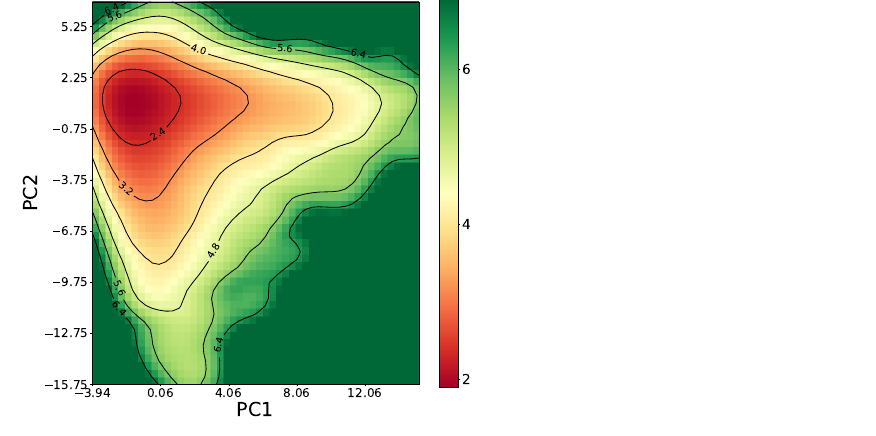
Figure 2. A 2D histogram is showing the structure of true positive using FPKM training data.